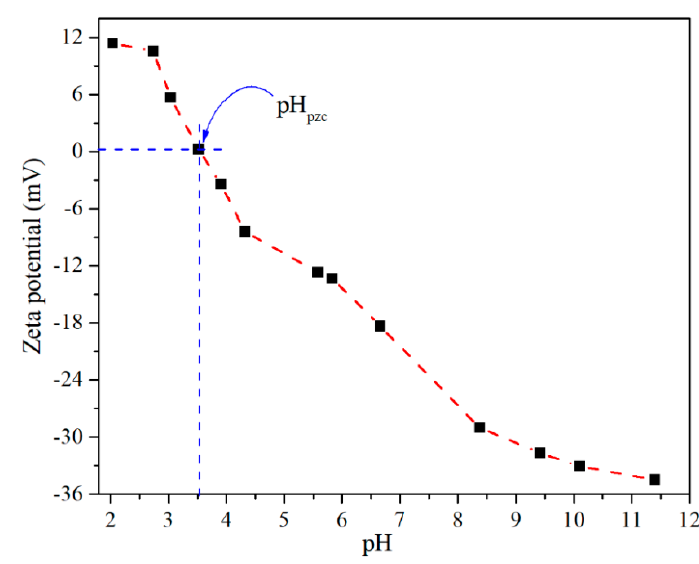
Figure 5. Zeta potential of CTO at pH between 2 and 11.